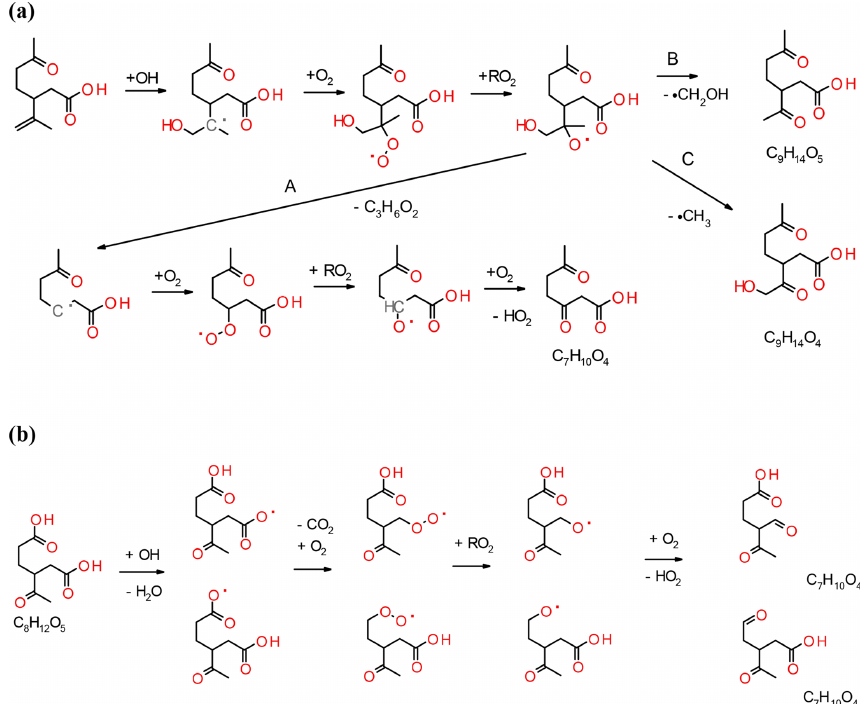
Figure 6. (a) Secondary chemistry of the addition of OH to the unsaturated double bond of the primary product limononic acid and the subse- quent formation of C 7 H 10 O 4 , C 9 H 14 O 5 and C 9 H 14 O 4 . (b) Secondary chemistry of a selected saturated carboxylic acid product (C 8 H 12 O 5 ) giving the observed C 7